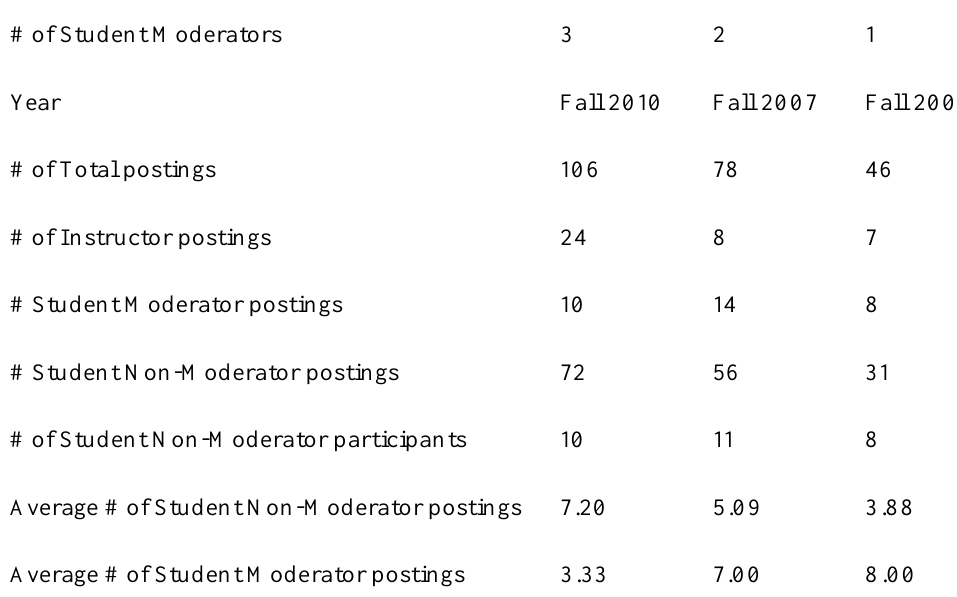
Numeric Participation and Average Number of